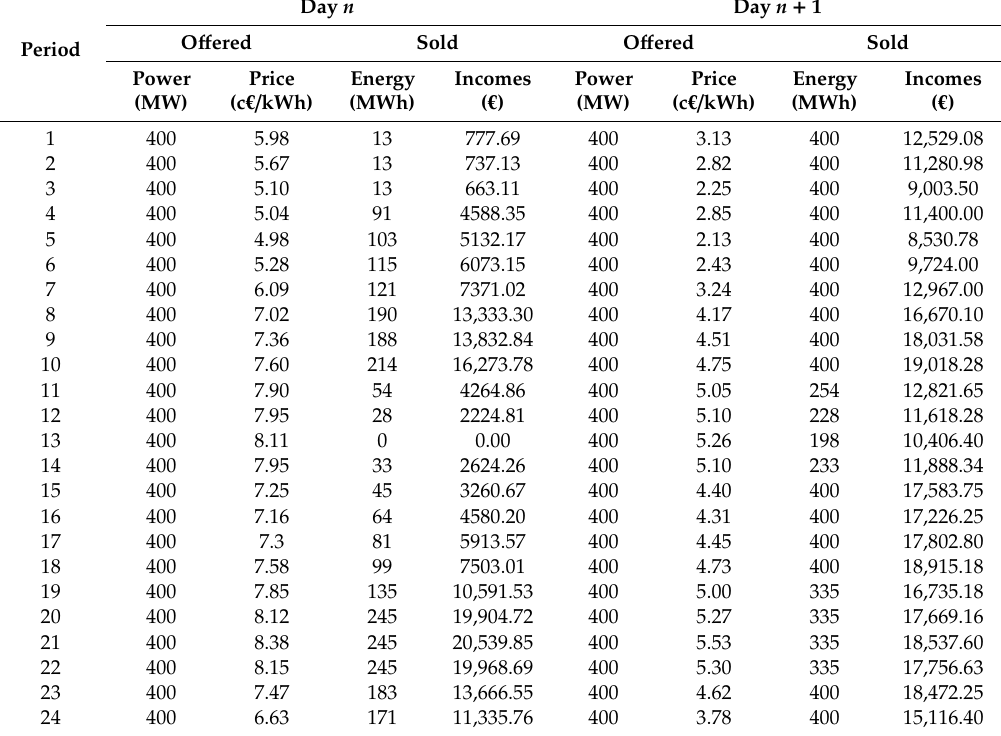
Table 6. Comparison between the values of the bids and the gains using strategy 3.